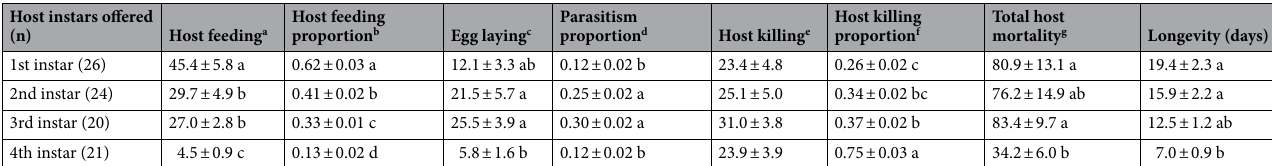
Table 1. Life history traits of Necremnus tutae females when different instars of Tuta absoluta were offered. a No. of hosts fed upon. b Host feeding/total host mortality. c No. of hosts parasitized. d Egg laying/total host mortality. e No. of hosts stung without feeding upon them. f Host killing/total host mortality. g Total no. of dead